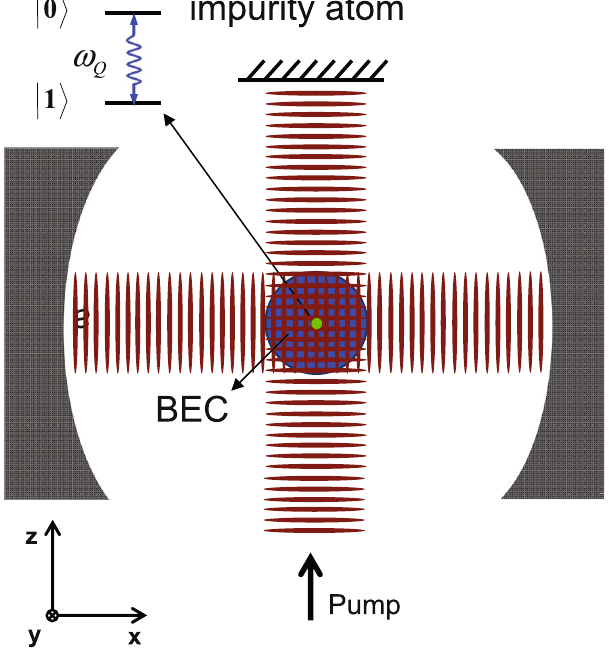
Figure 1. Schematic of the physical system under consideration: An impurity qubit with energy separation ω Q is doped into a atomic BEC in a ultrahigh-finesse cavity. Both the impurity and BEC couple to a single cavity field and a transverse pump